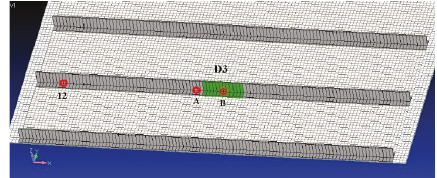
Figure 56: Positions of the measuring nodes for decay tests, damage D3.